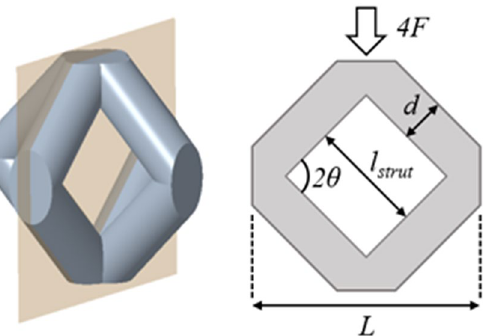
Figure 3. Parameters to obtain the maximum tensile stress in each strut by using the Local Stress Method.